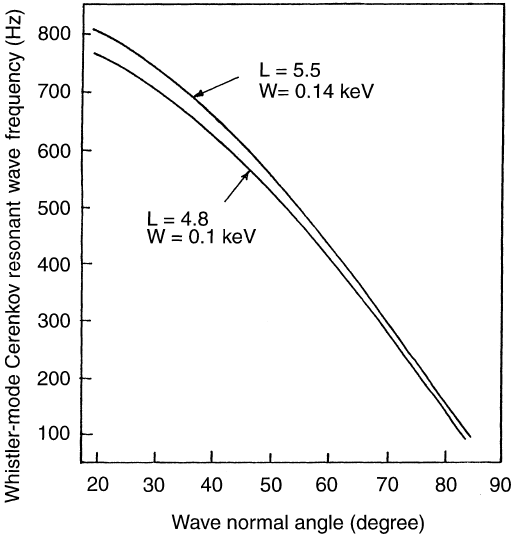
Fig. 2. Plots showing variation of whistler-mode Cerenkov resonant wave frequency with wave